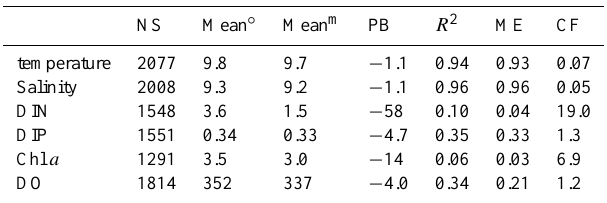
(Fig. 3). The temporal evolution of vertical profiles of the model (Fig. 13a) matches well that of observations in